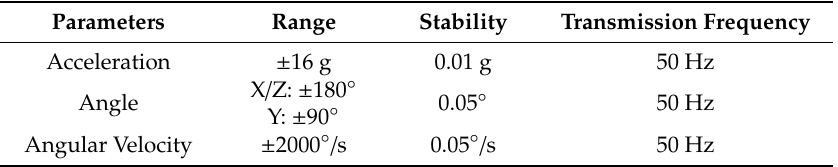
Figure 1. The placement and orientation of the inertial measurement unit (IMU) on the posterior heel region. Table 1. The specifications of Table 1. The specifications of BWT901BLE5.0.